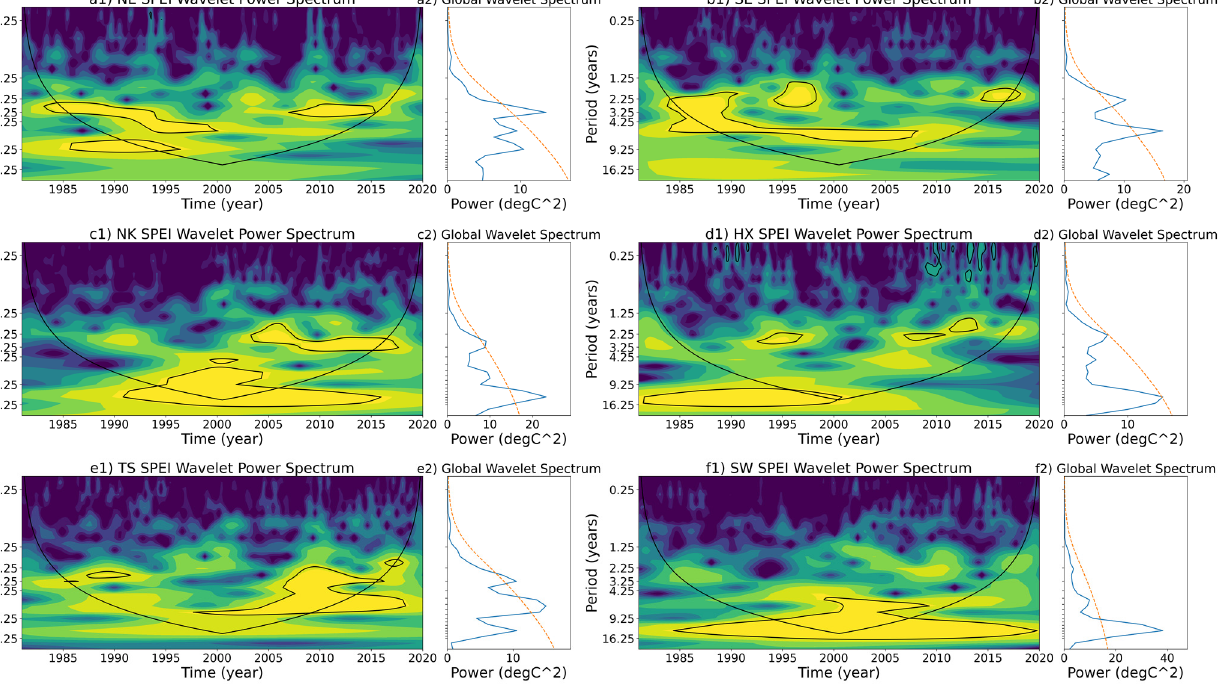
Figure 9. Wavelet power spectrum and global wavelet spectrum after Morlet wavelet transform based on SPEI12. Subplots ( a1 – f1 ) represent wavelet power spectrum in different subregions, ( a2 – f2 ) represent global wavelet spectrum in different subregions.